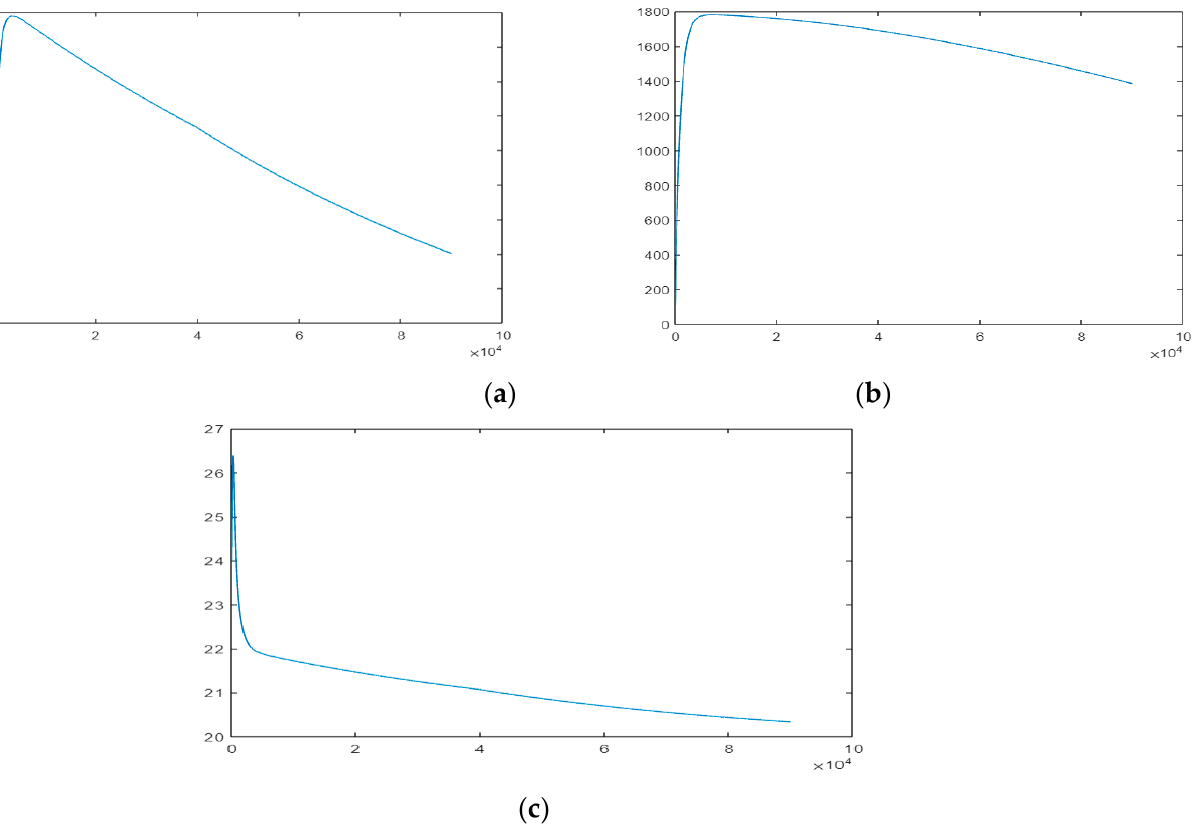
Figure 20. Simulation of condenser flow ( a ) heat ( b ) and cooling water temperature ( c ). Statistical metrics represented in Tables 6–8 are able to provide information on the overall performance of the developed models and their comparison with state-of-the-art proposed models.